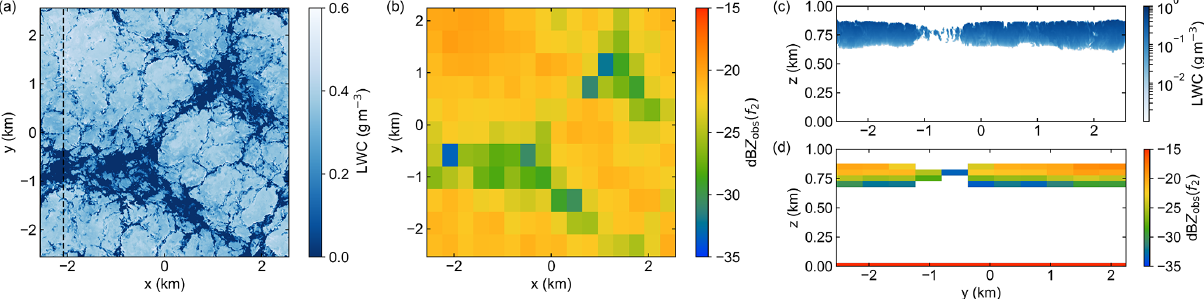
Figure 10. Selected results from DYCOMS-II forward simulations. (a) Model cloud LWC field for z = 820m. (b) Corresponding observed reflectivity map at 174.8GHz for the range bin centered at 800m height. (c) Vertical LWC profiles for the along-track path indicated by the dashed line in panel (a) (note the reversed color scale with respect to a ) and (d) corresponding 174.8GHz observed reflectivity profiles.